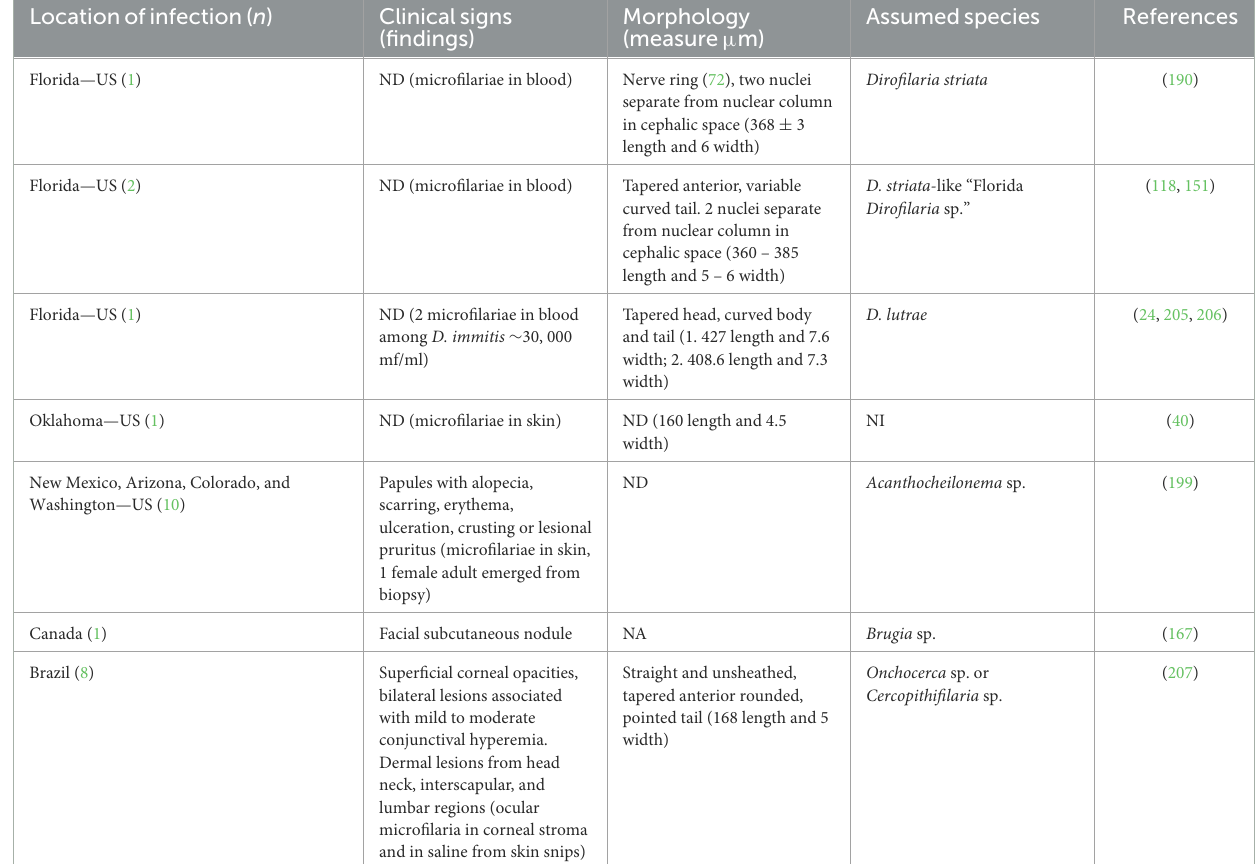
TABLE 3 Microfilariae that do not fit morphologically with known species of occurrence in the